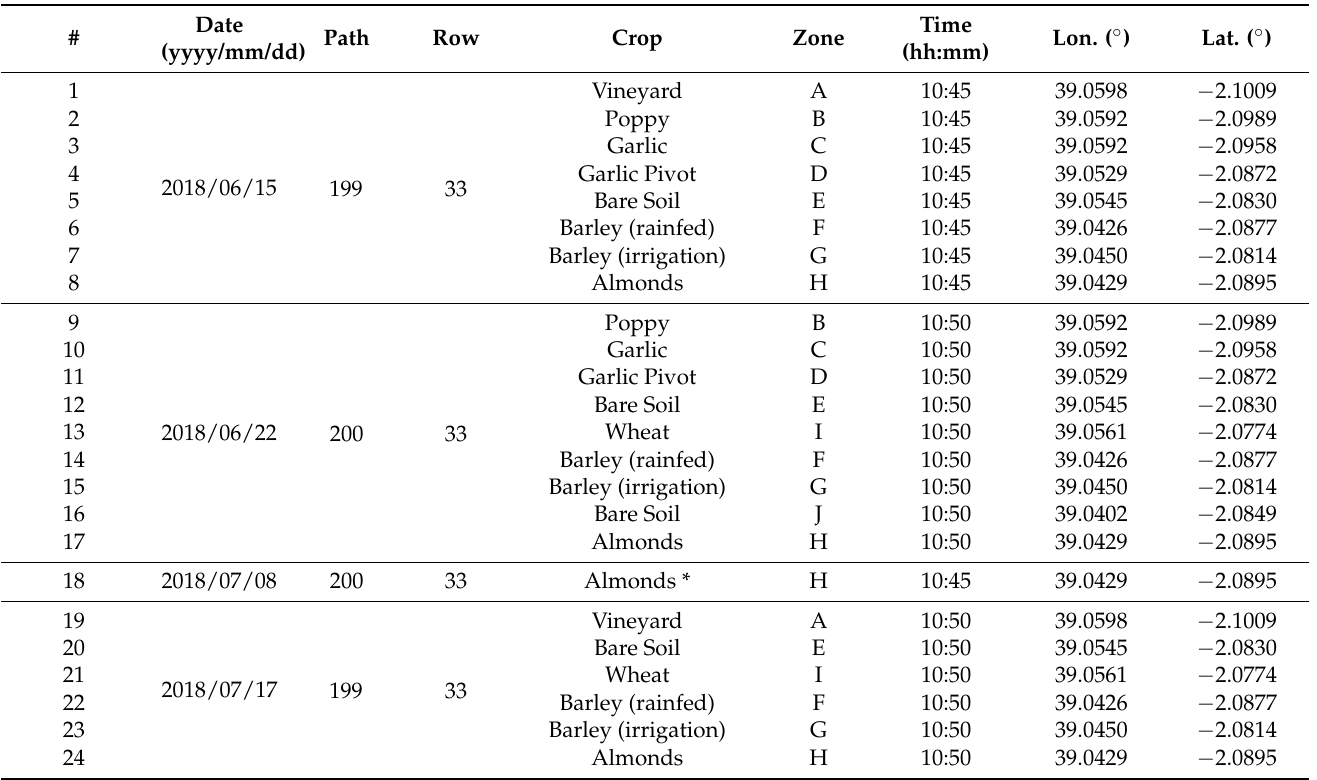
Table 2. Landsat 8/TIRS scenes used in this work. Information on the field crop and location coordinates is